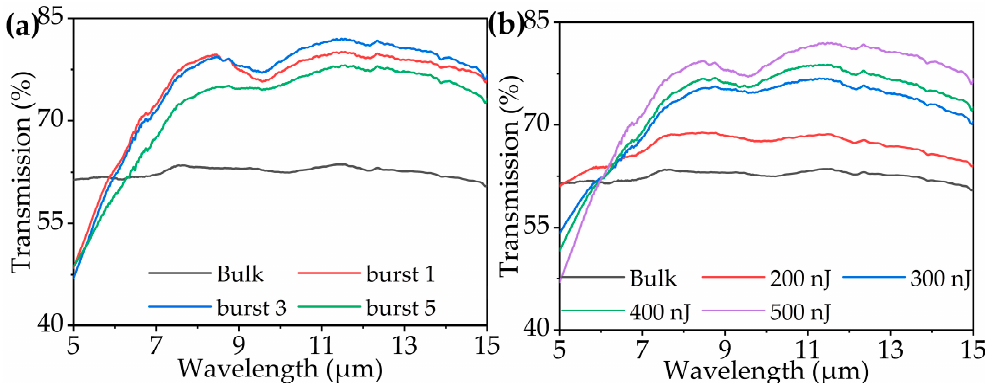
Figure 5. ( a ) Transmission of the ARMs in burst mode with the 500 nJ of single-pulse energy nJ in the range of 5–15 µm. ( b ) Transmission of the ARMs in burst 3 mode with the single-pulse energy from 200 nJ to 500 nJ in the range of 5–15 µm.